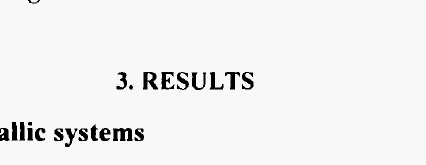
Fig. 3: A comparison between model predicted and experimental surface tension values of Cu-Co system at 1773K.